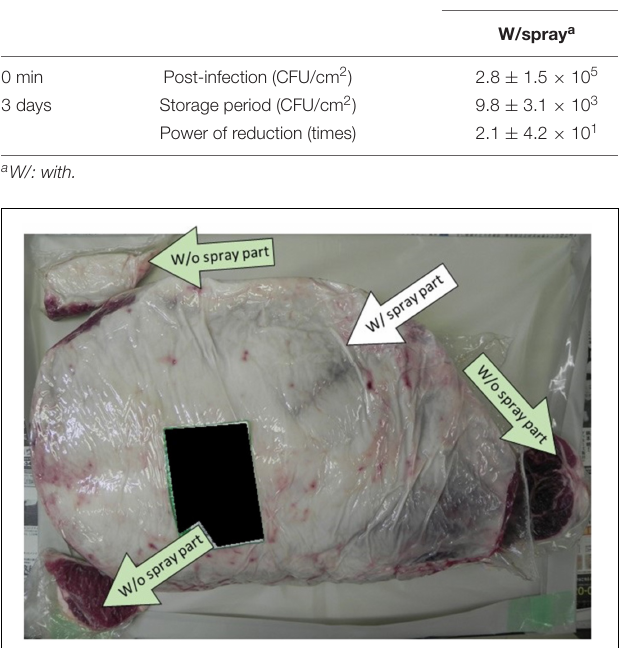
FIGURE 5 | Showing the positions where the spray method with calcium hydroxide–ethanol–lactate (CEL) disinfectant was applied on the beef